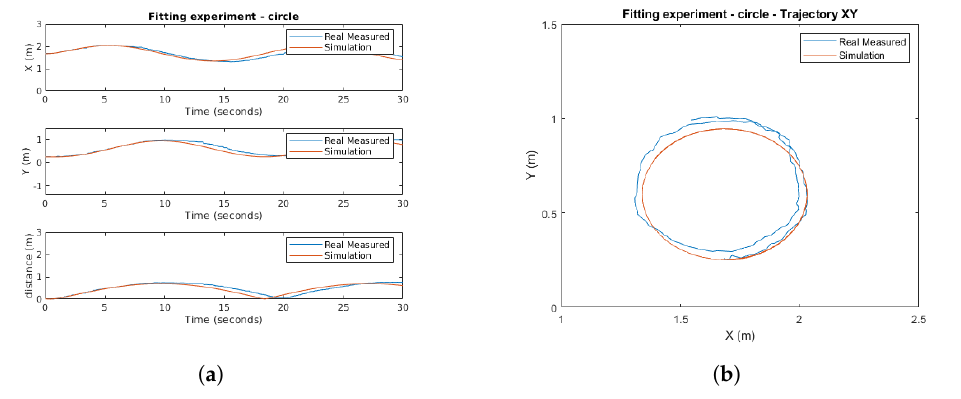
Figure 10. Circular trajectory. ( a ) Output with respect to time. ( b ) X-Y